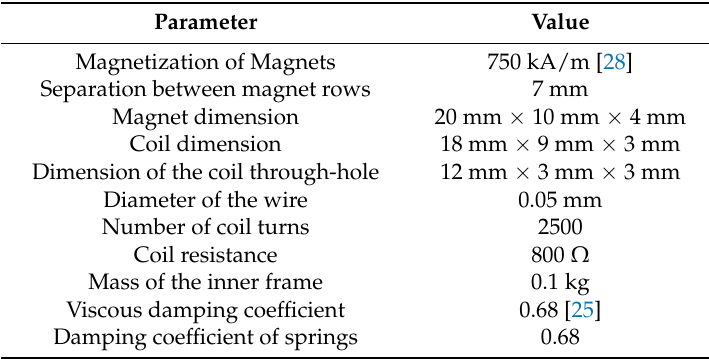
Table 1. Parameters of the harvester in simulations.